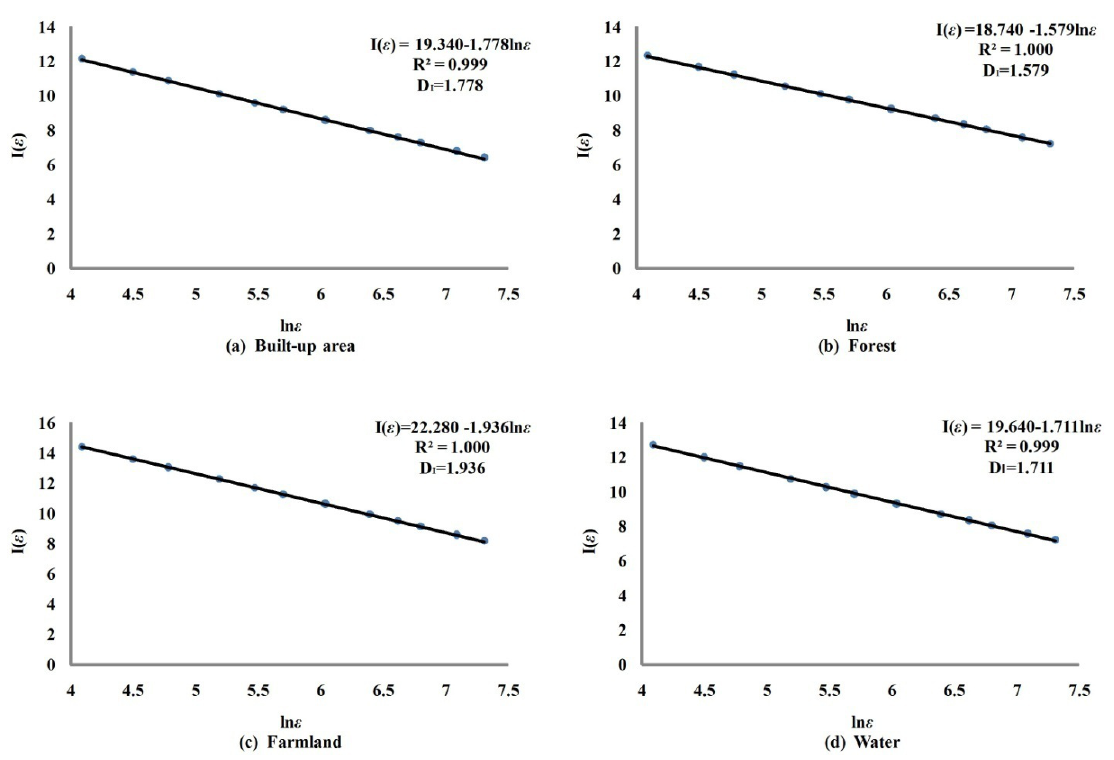
Figure 8. The information entropy dimension results for four land use types in Wuhan